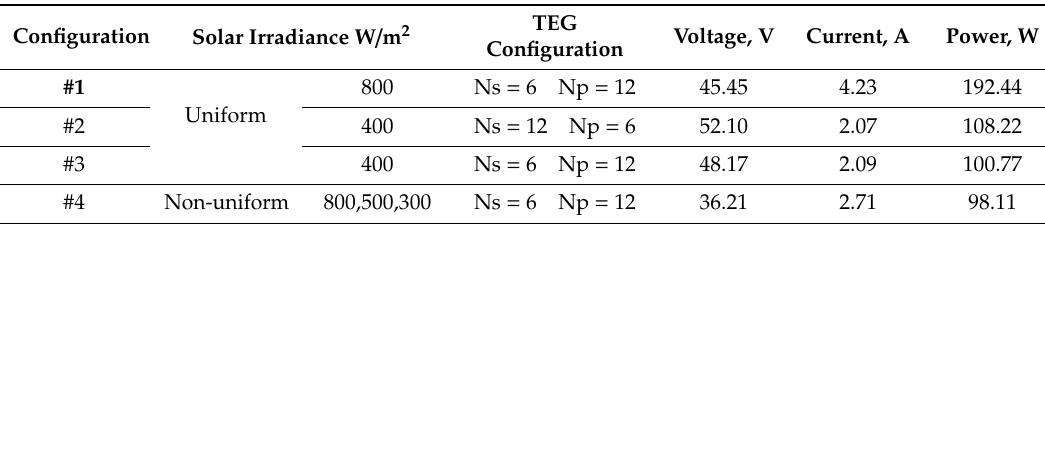
Figure 10. Power vs voltage curves of HPVTEG under different conditions.